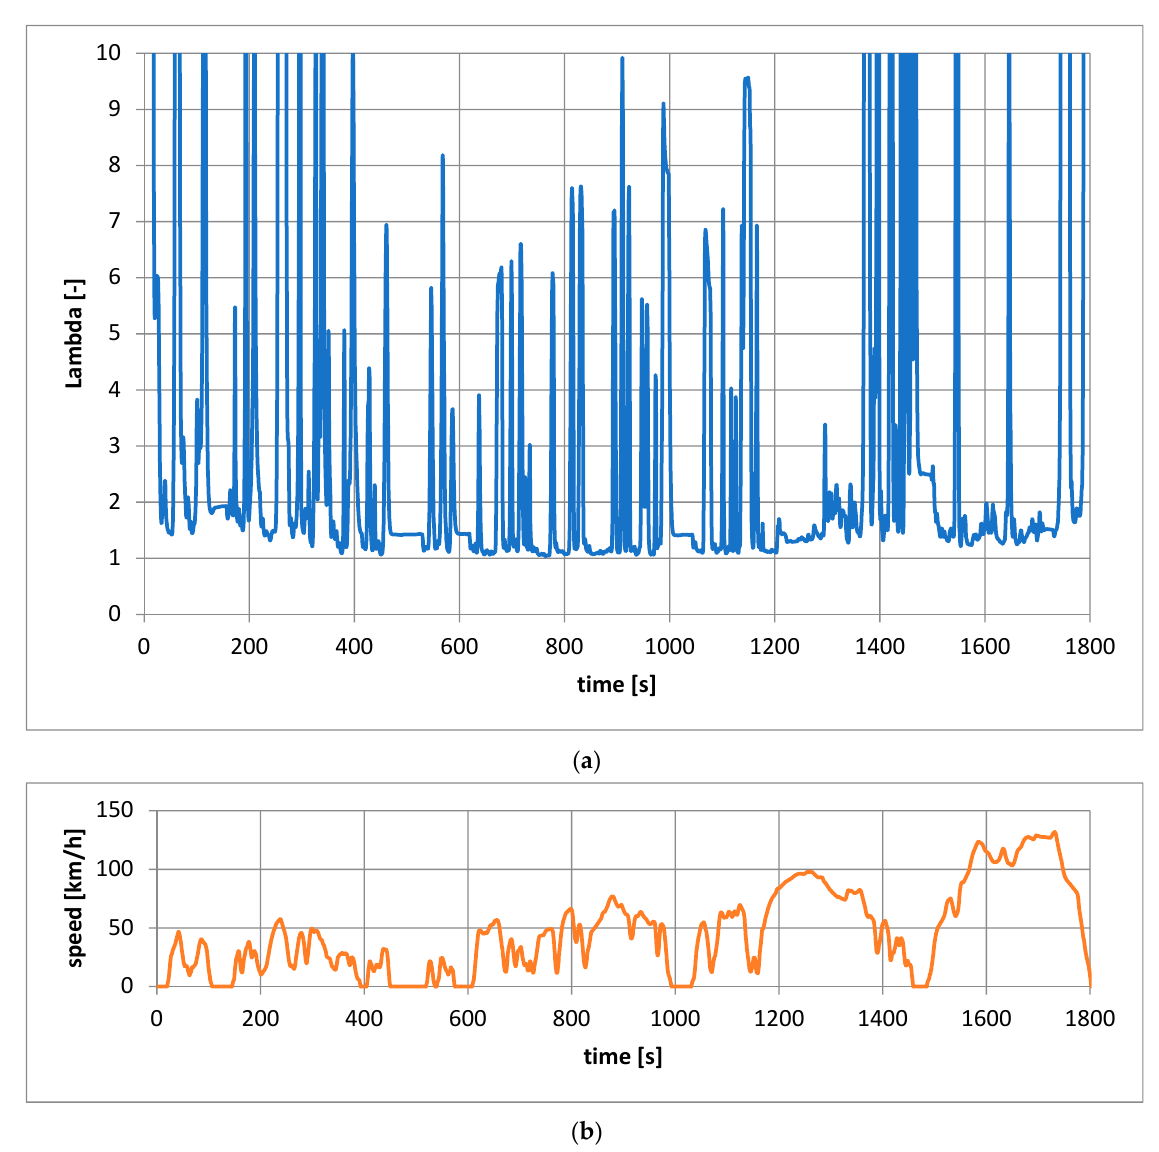
Figure 7. ( a ) Instantaneous values of λ (Lambda) in WLTC for a vehicle equipped with a compression ignition engine, ( b ) real vehicle speed in WLTC cycle.